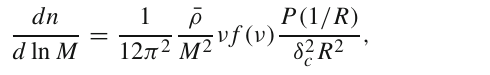
Fig. 8 Massfunction(leftpanel)andRedshiftwherethematterpertur- bation reach the non-linear regime in function of the scale (right panel). In both cases the solid line corresponds to Λ CDM model, the dashed